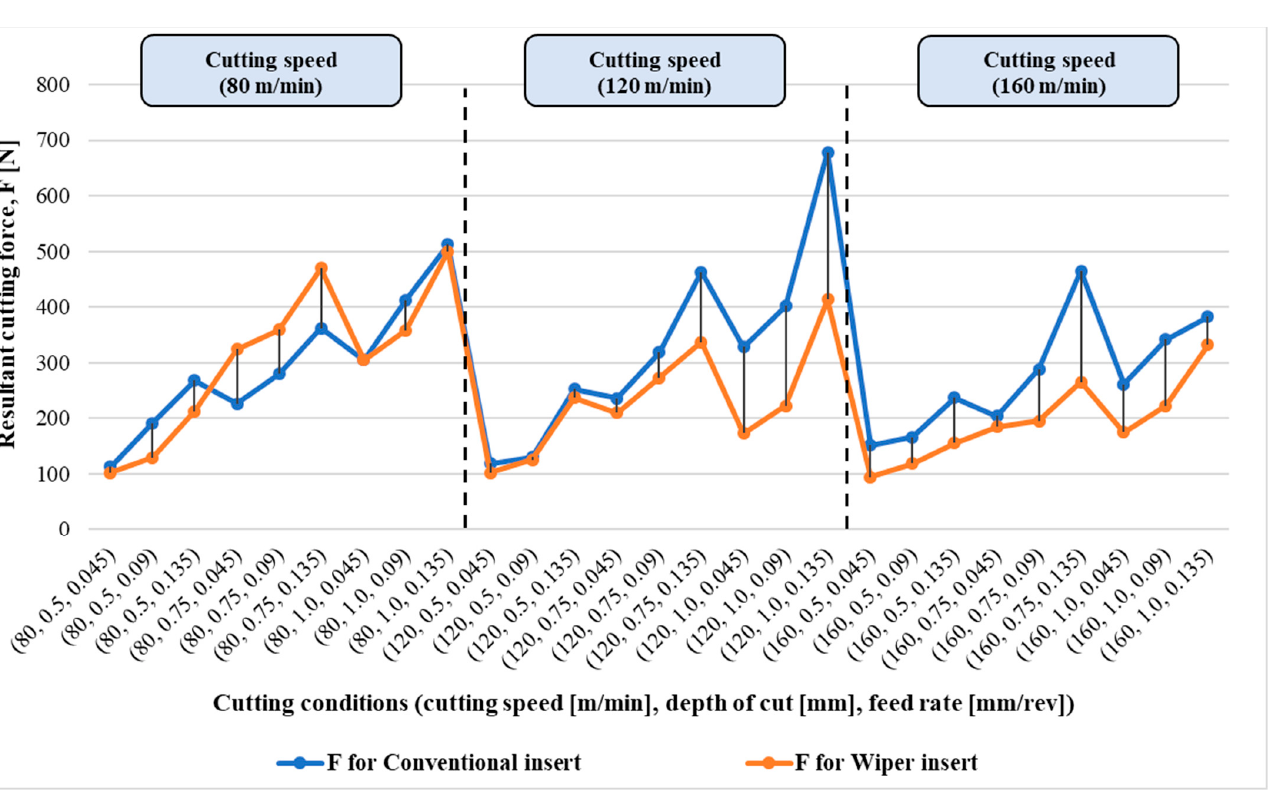
Figure 7. Resultant cutting force, F in N for both cases, of conventional and wiper inserts under a range of cutting conditions.